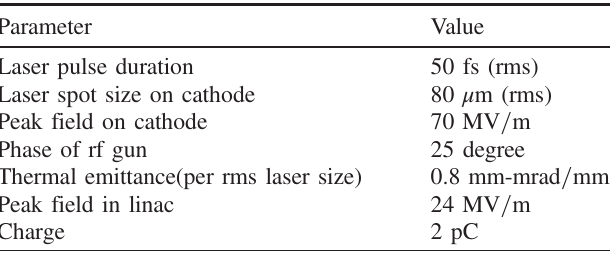
TABLE I. Pegasus beam line velocity bunching parameters for 2 pC beam charge case.